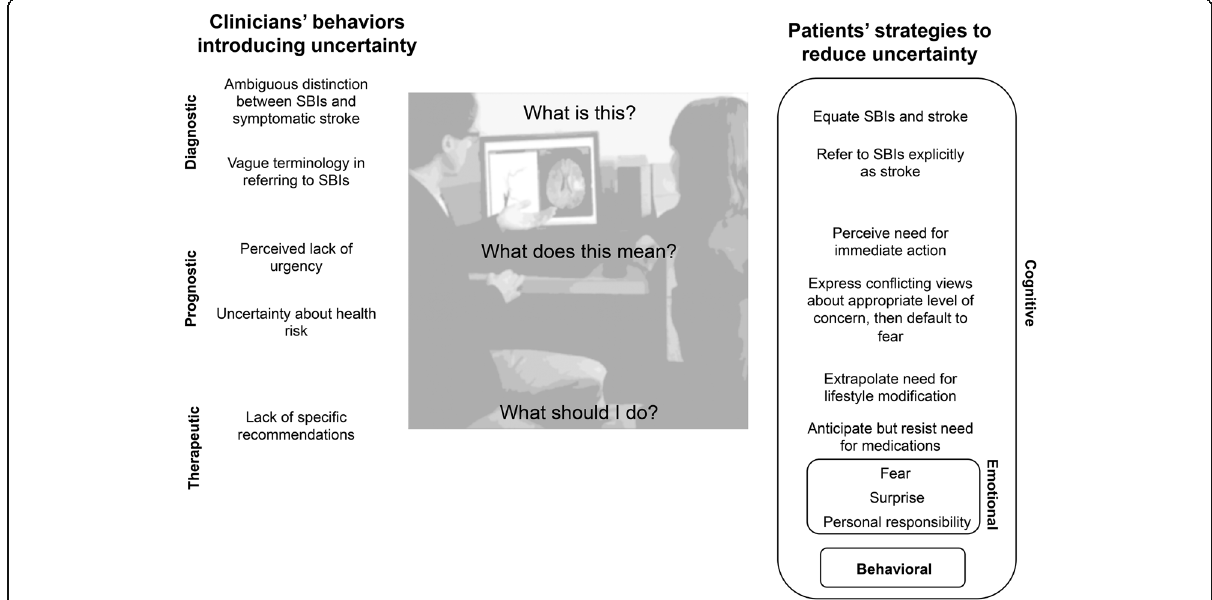
Fig. 3 Uncertainties introduced by clinician behavior and participants ’ strategies to reduce